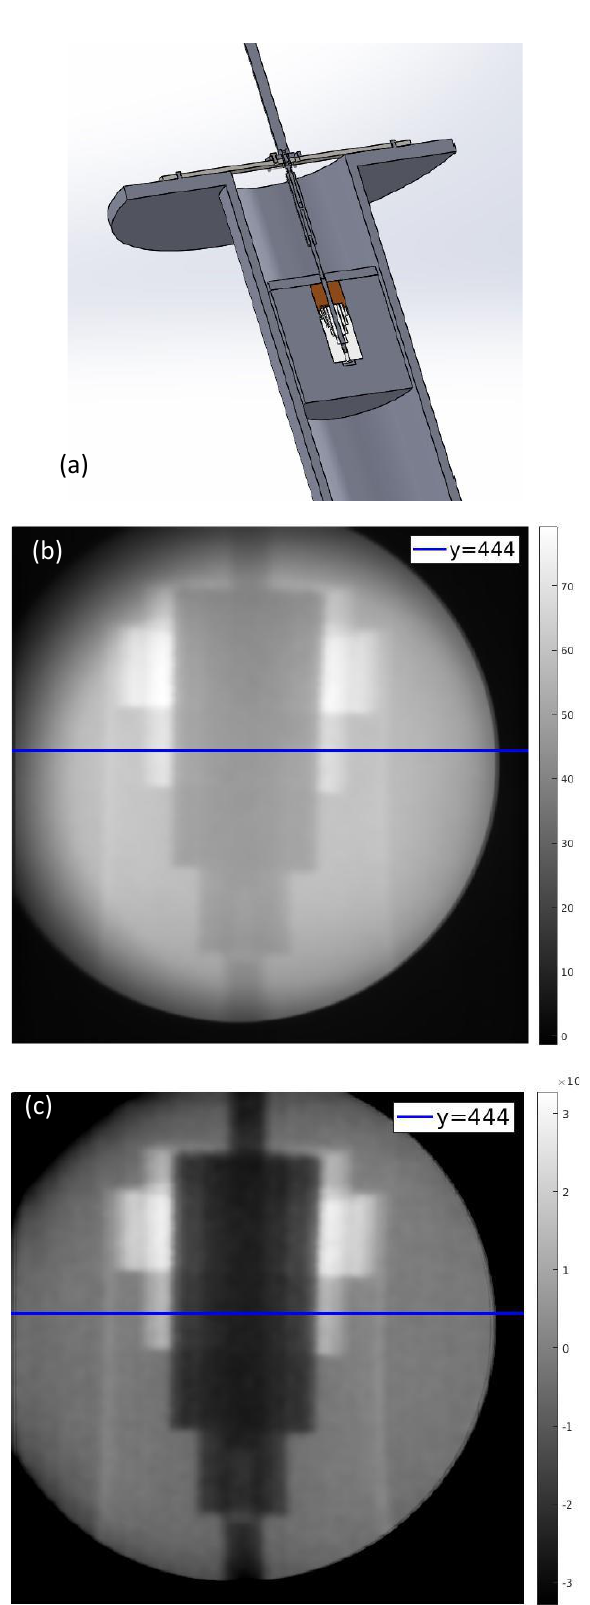
Fig. 2. (a) A schematic of phantom 2 installed in the test section, (b) a denoised X-ray image of phantom 2 with its 2 inner rings filled with steel balls, and (c) a log-flat field normalized version of (b) equalized by a factor of 10⁵.